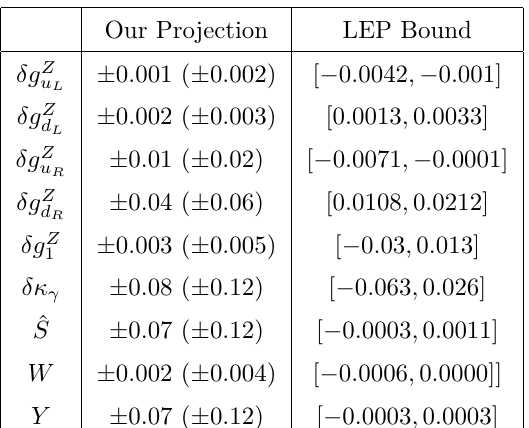
Table 4 . Table shows the comparison of 68 % CL bounds extracted from the VBF analyses with the existing LEP bounds. The bounds outside the parentheses are projections for 3 ab − 1 data and those inside are for 0.3 ab − 1 data. To get our projection, we demand that each term in eq. (4.5) respects the bound in eq. (4.2). The LEP bounds on the Z -boson couplings to quarks, δg Z taken from ref. [12], the bounds on the charged TGCs are taken from ref. [73], the bound on ˆ S from ref. [74], and the bounds on the W, Y observables from ref.